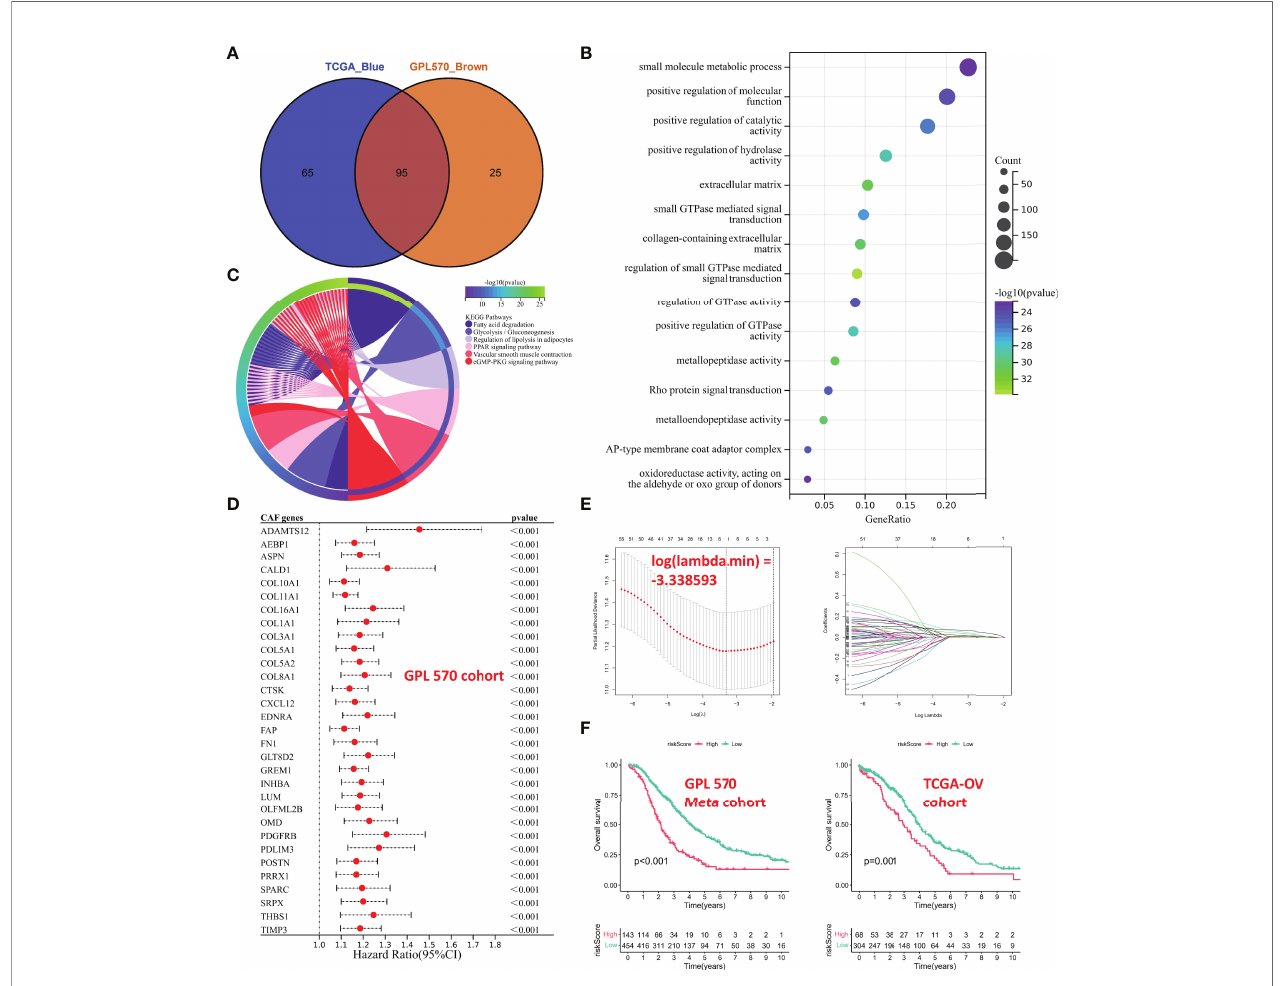
FIGURE 4 | Functional analyses and construction of the CAF-based signature. (A) The hub CAF-related genes were overlapped in the brown module and the blue module. (B) GO enrichment analysis. (C) KEGG enrichment analysis. (D) Univariate Cox regression analysis of common hub genes (P < 0.001). (E) LASSO regression analysis. (F) Kaplan – Meier analysis of different cohorts. On the left is GPL570 meta-cohort; on the right is TCGA-OV cohort. CAFs, Cancer-Associated Fibroblasts; GO, Gene Ontology; KEGG, Kyoto Encyclopedia of Genes and Genomes; LASSO, Least Absolute Shrinkage and Selection